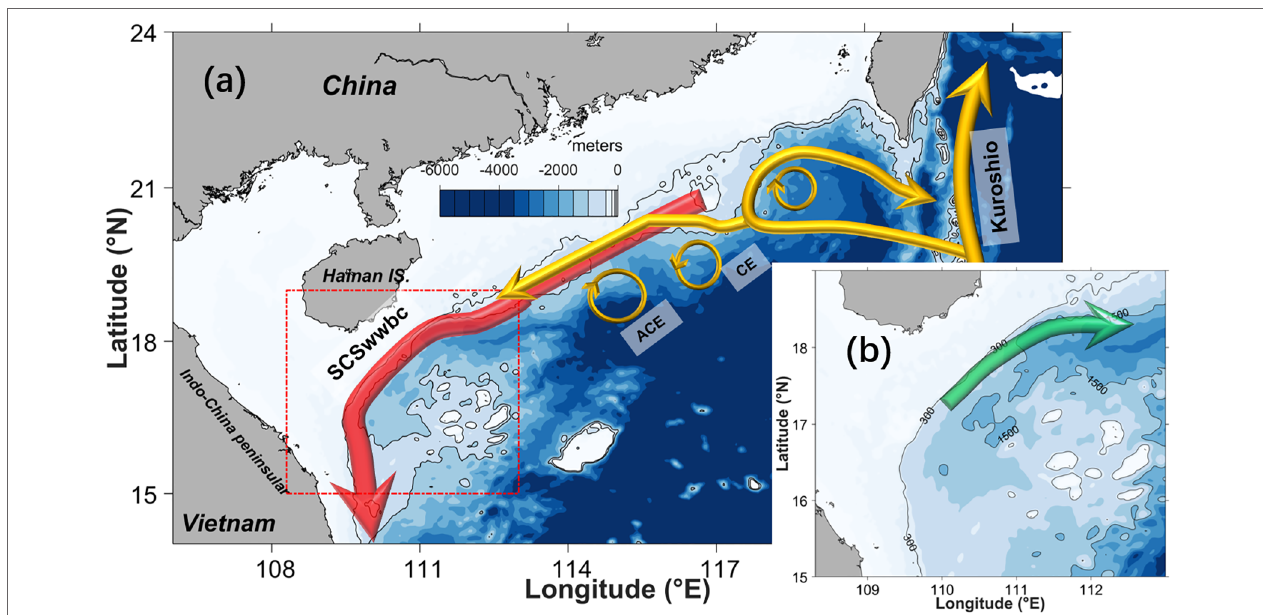
FIGURE 1 | (A) Schematic diagram of the circulation in the northern SCS. SCSwwbc: winter western boundary current of the SCS; ACE, anticyclonic (warm) eddy; CE, cyclonic (cold) eddy. (B) The geographical extent of the study region which is delineated by red dotted box in (A) ; the green arrow represents the slope undercurrent; the solid black curves depict the 300 and 1500 m